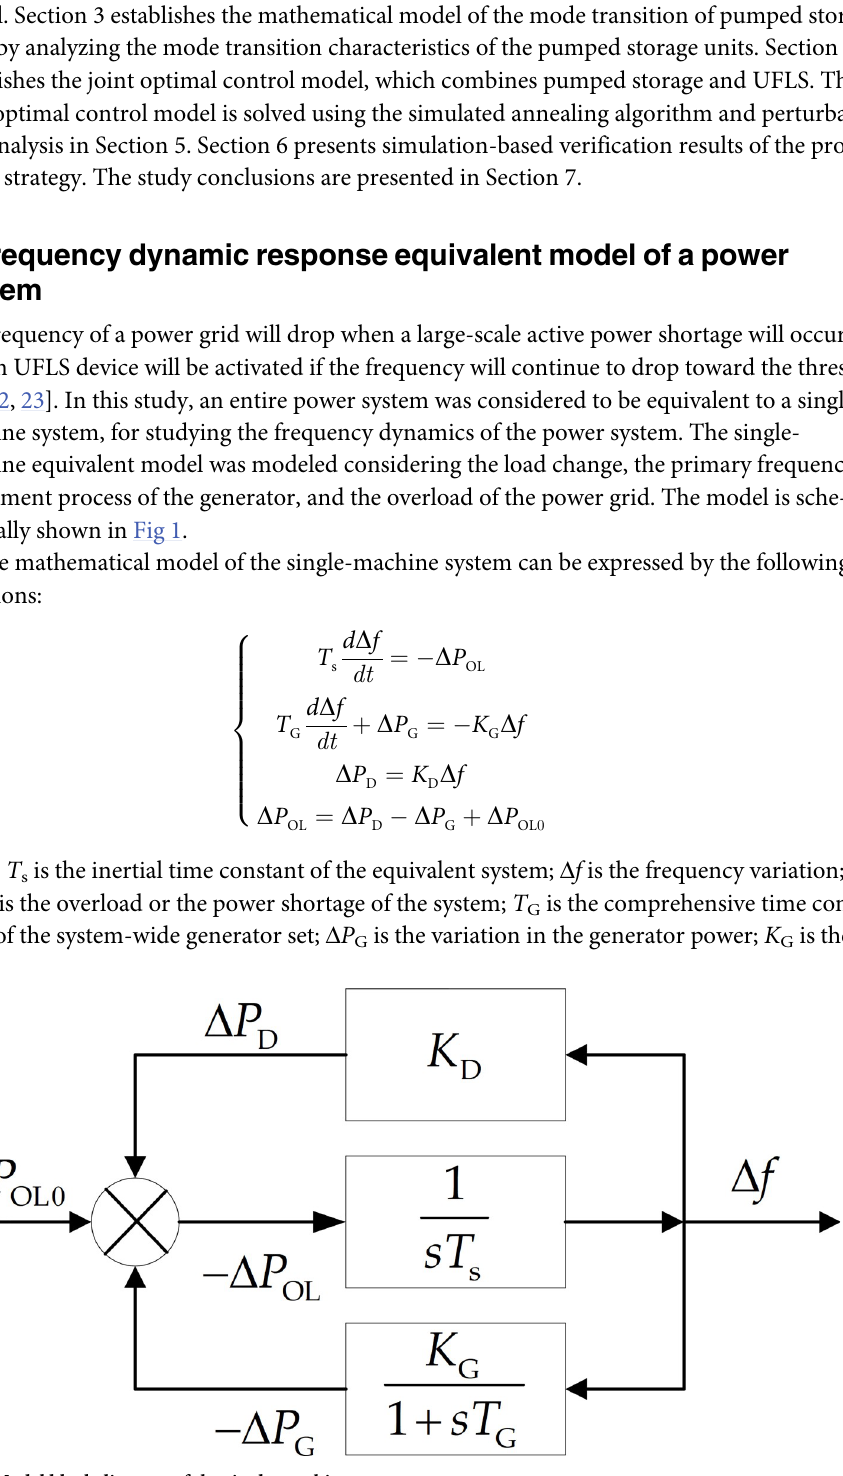
Fig 1. Model block diagram of the single-machine